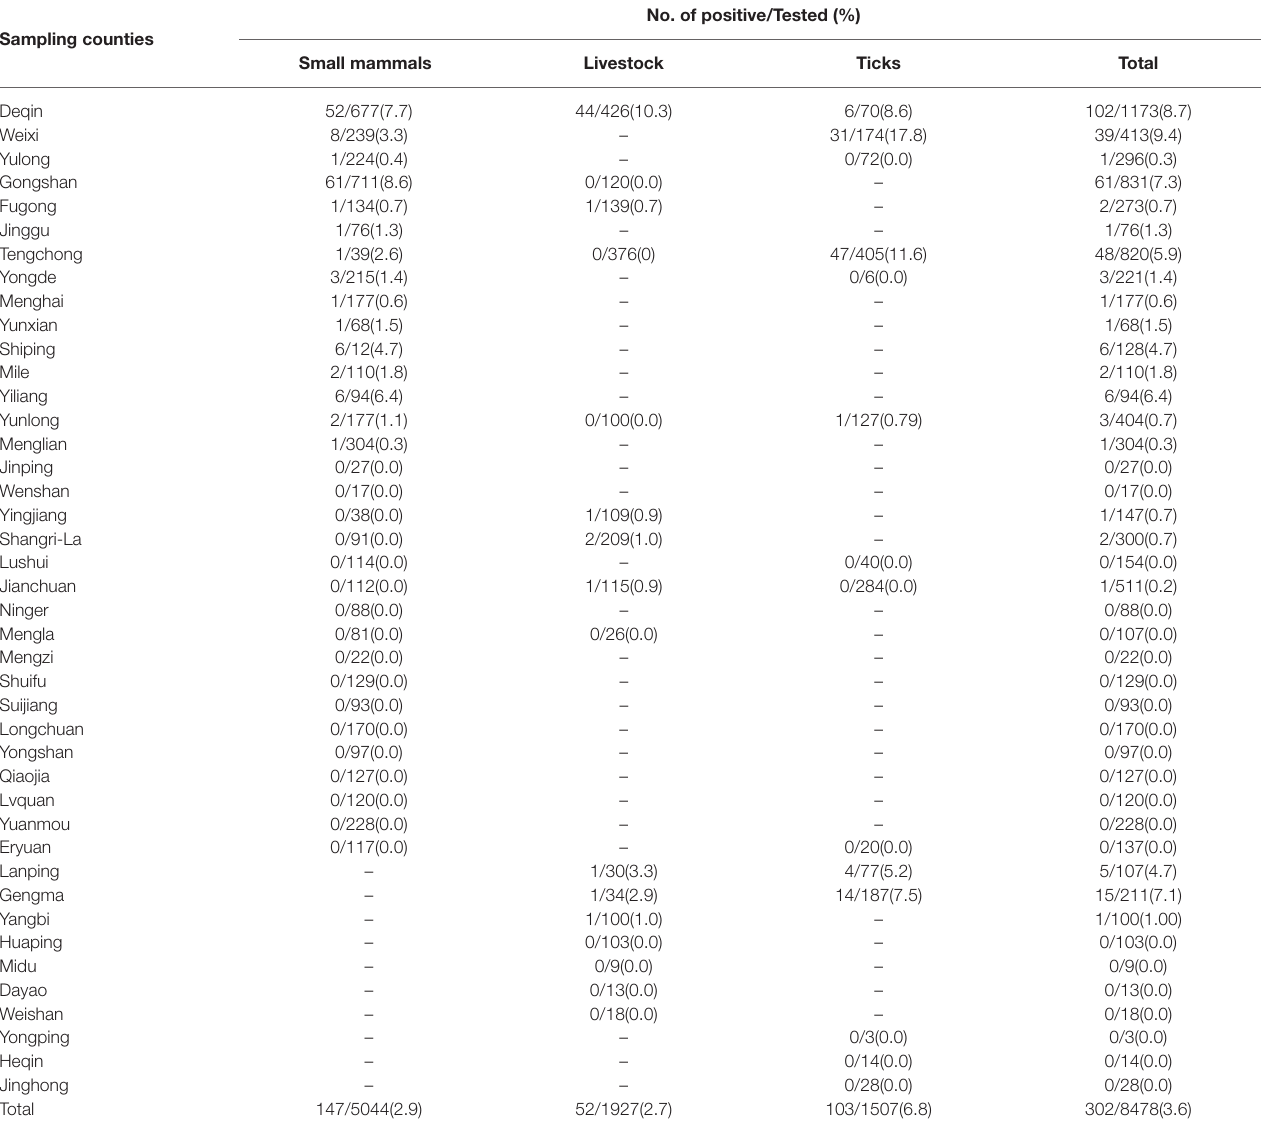
TABLE 1 | Prevalence of Borrelia burgdorferi sensu lato at different sampling sites.